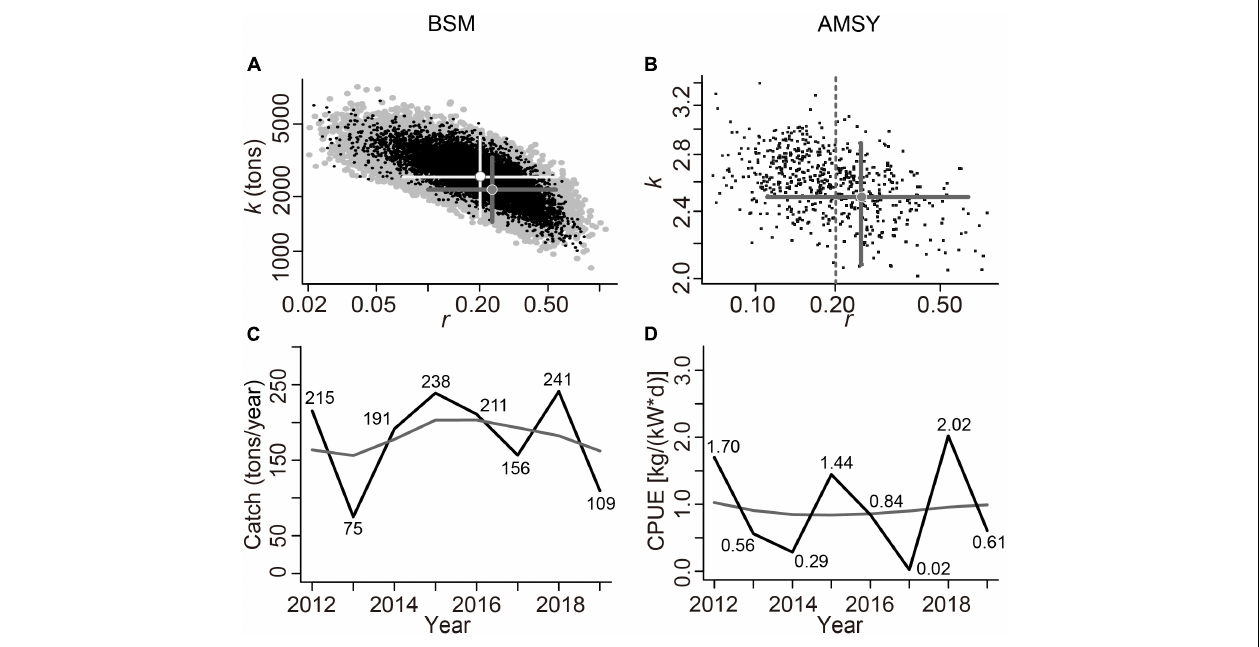
FIGURE 5 | Analysis of viable r - k pairs and stock size (Catch for BSM related to CMSY, CPUE for AMSY) by BSM and AMSY. Notice the match between the left and right panels. (A) Feasible r - k pairs identified by BSM (in black) related to CMSY (in gray) (B) feasible r - k pairs identified by AMSY; (C) Catch (in black) relative to the MSY (in gray) estimated by BSM; (D) CPUE (in black) relative to MSY (in gray) predicted by AMSY.